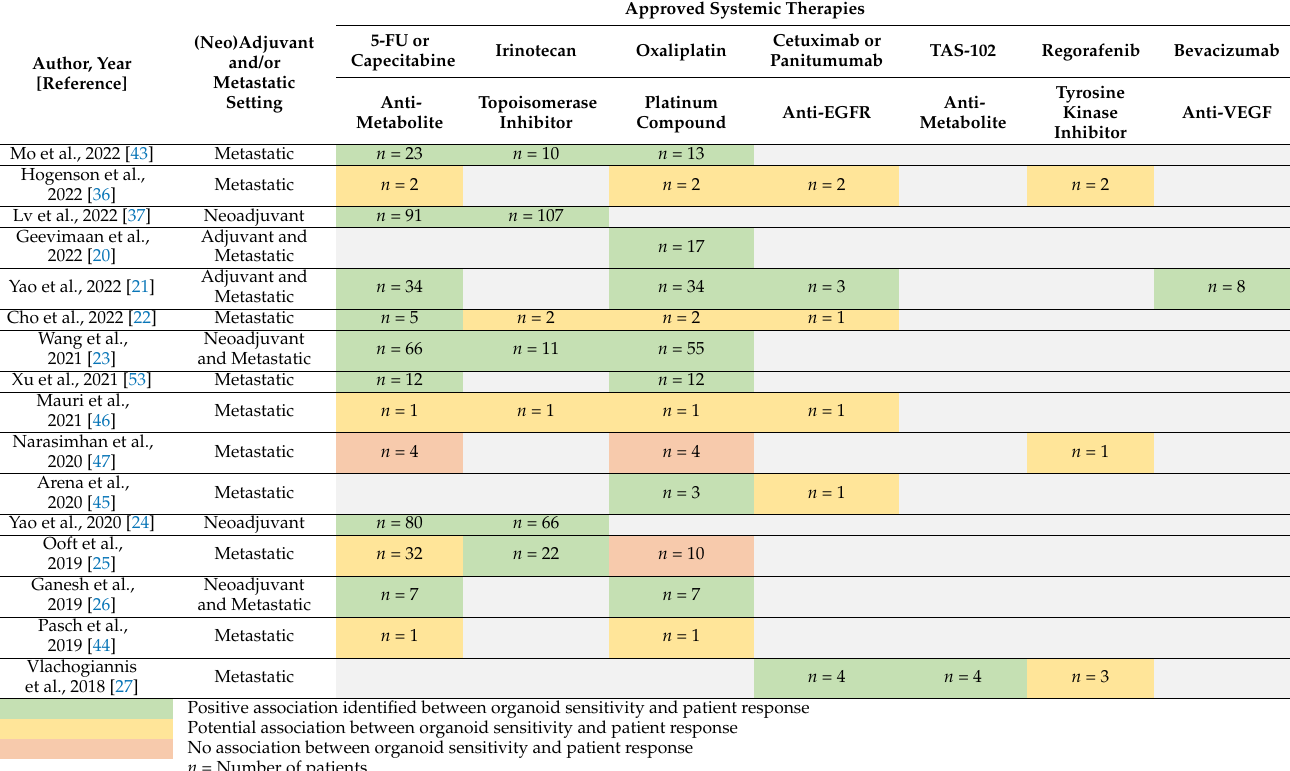
Table 1. Summary of studies associating organoid sensitivity and patient response to approved systemic